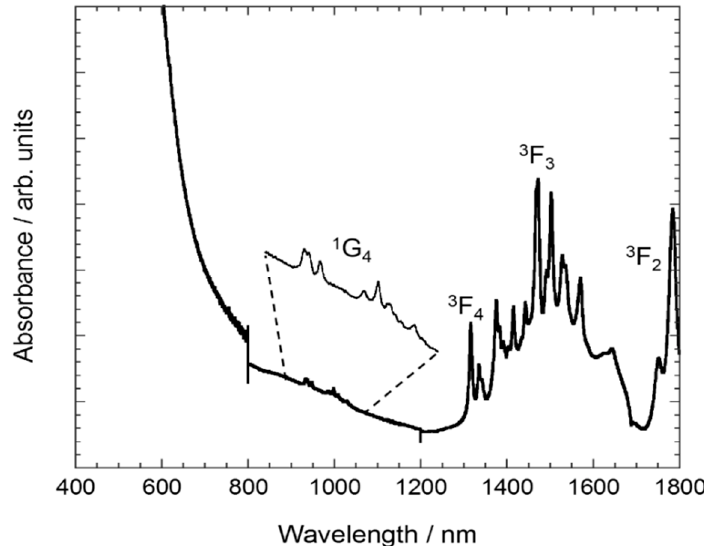
Figure 3. Absorption spectrum of Y 2 O 3 : Pr 3+ NCs obtained by sol–gel Pechini method using citric acid as chelating agent and followed by thermal treatment at 900 °C for 16 h.